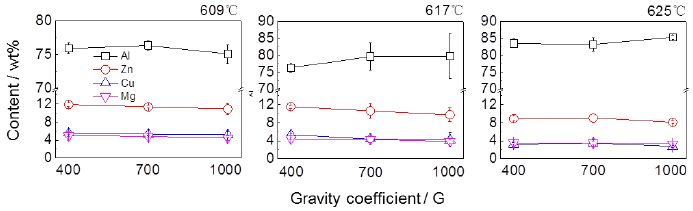
Figure 9. The compositions of filtrates obtained under different gravity coefficients.